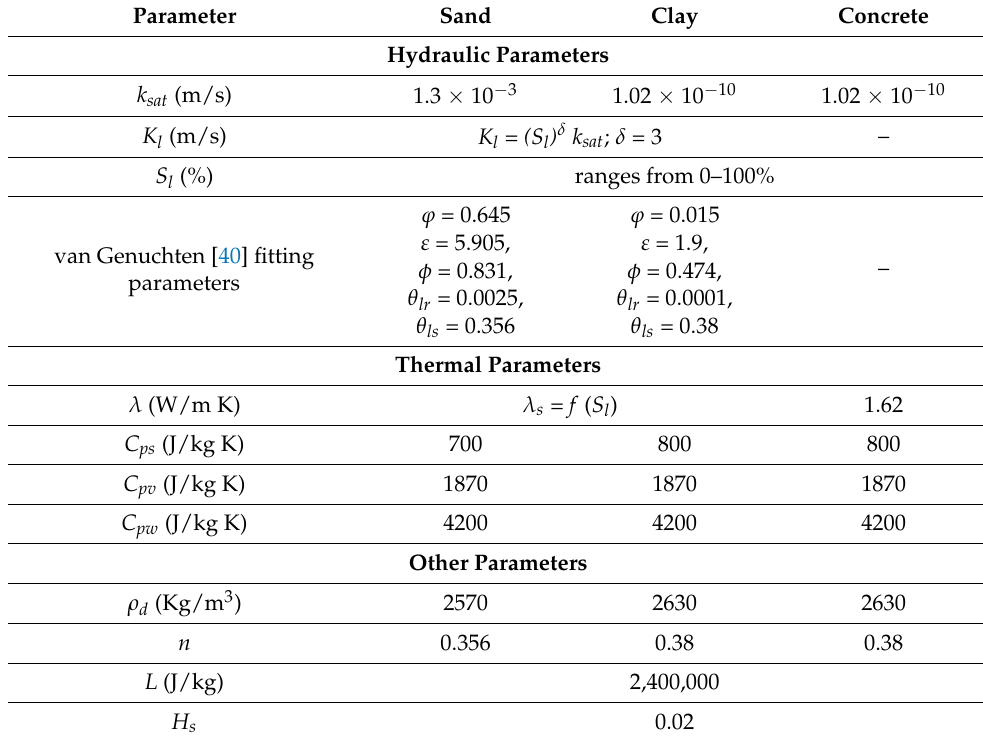
Table 3. The material parameters. Parameter Sand Clay